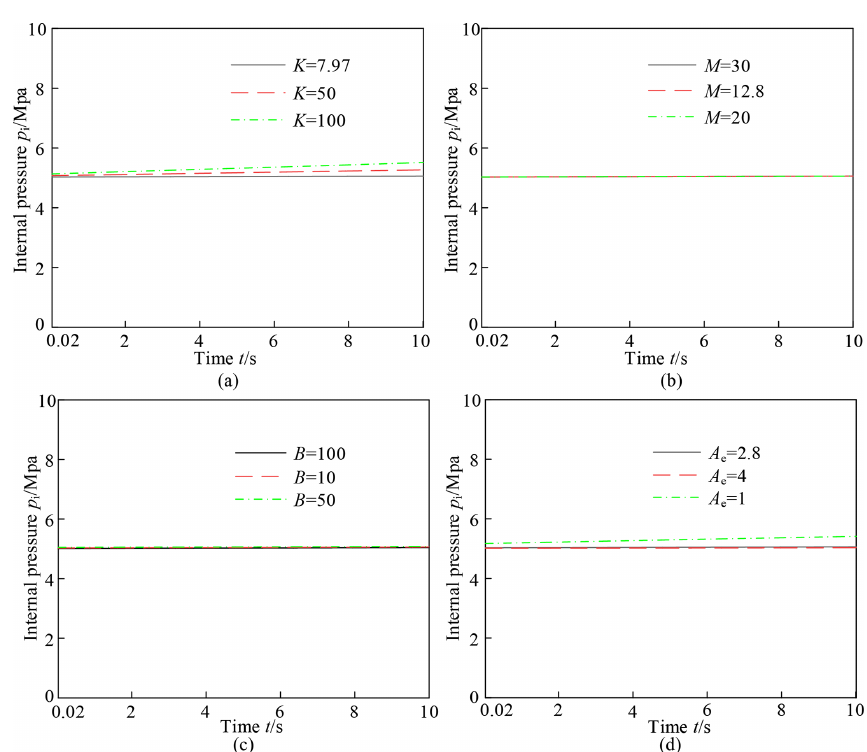
Figure 10. Internal pressure variation within